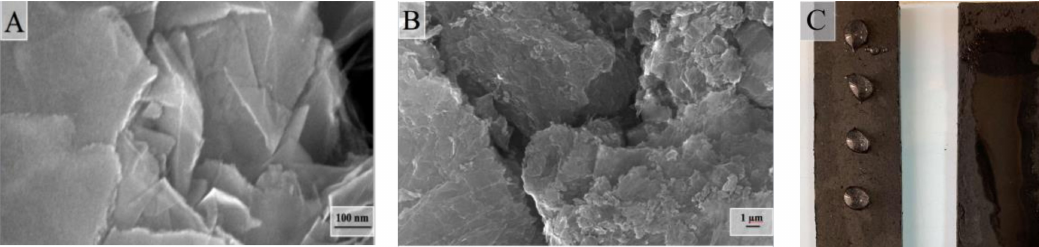
Figure 14. Micrographs of a single granule of mesoporous activated carbon ( A ), the surface of the electrode material ( B ), and photographs of the electrodes before and after hydrophilization ( C